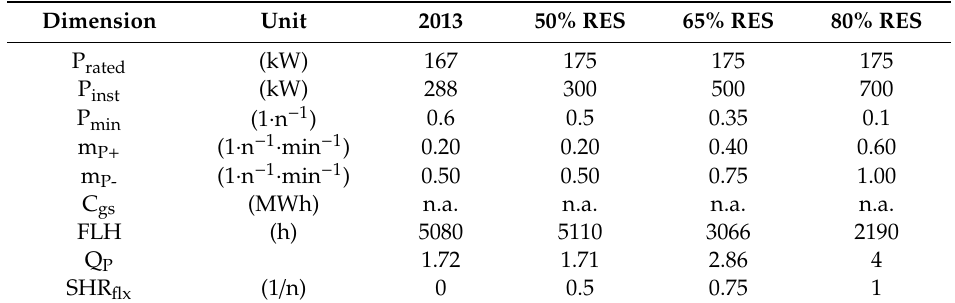
Figure A1. Residual load duration curves of the six different scenarios in the wind ‐ dominated region, showing how the residual loads throughout the sorted annual load values are composed in the three different time periods and either a classical or VAREO optimized mix (dashed lines) of wind and solar PV. Table A3. Parameter set for biomethane ‐ CHPU reference plant modified and expanded according to [25].